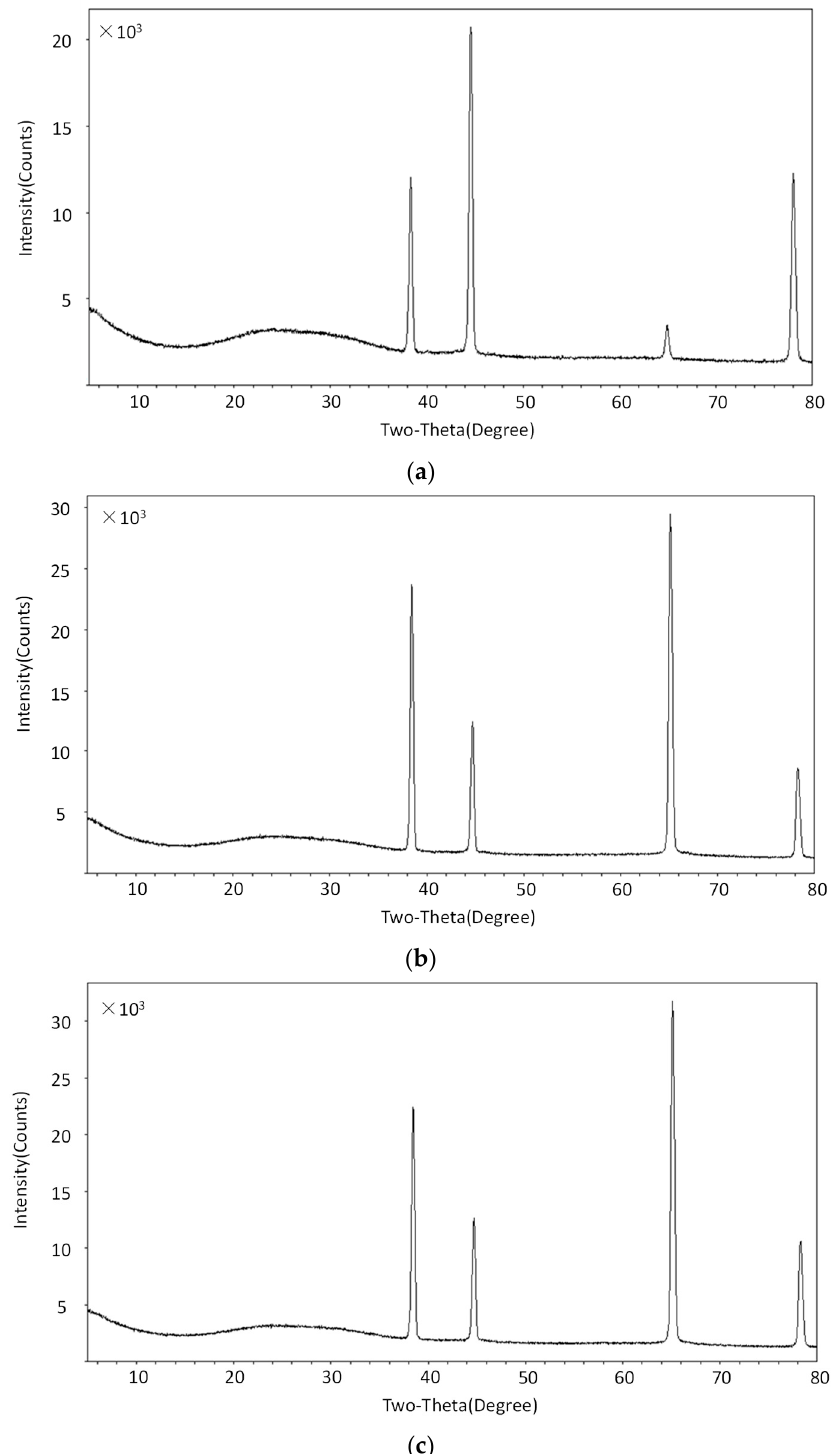
Figure 7. The XRD results of ( a ) untreated aluminum alloy, ( b ) laser treated aluminum alloy, and ( c ) cleaned laser treated aluminum alloy sample #1. and ( c ) cleaned laser treated aluminum alloy sample